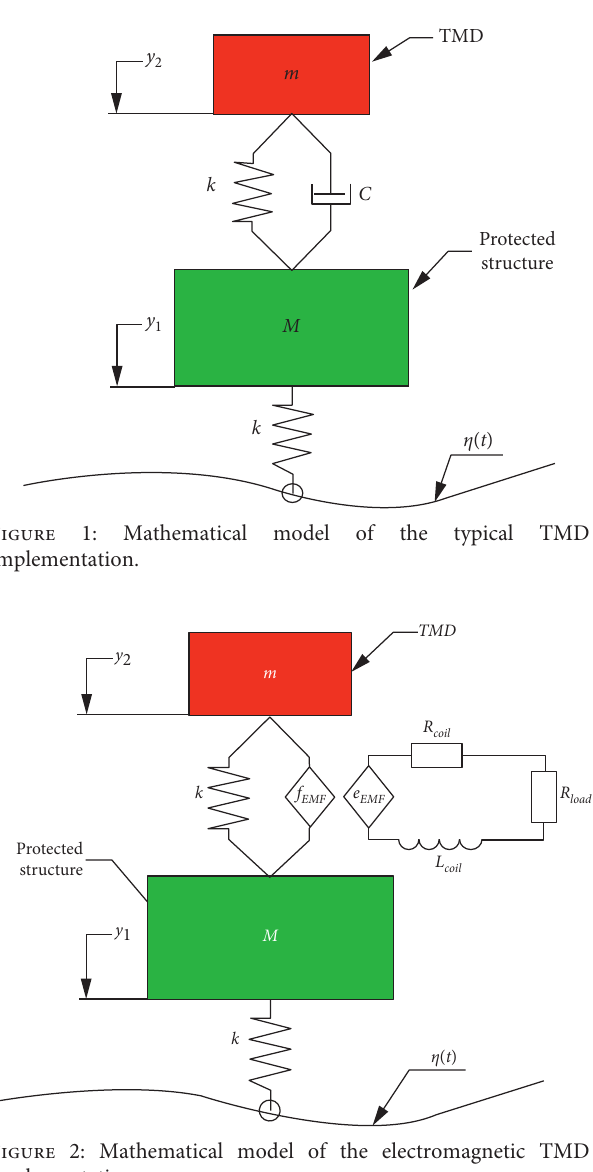
Figure 2: Mathematical model of the electromagnetic TMD implementation.